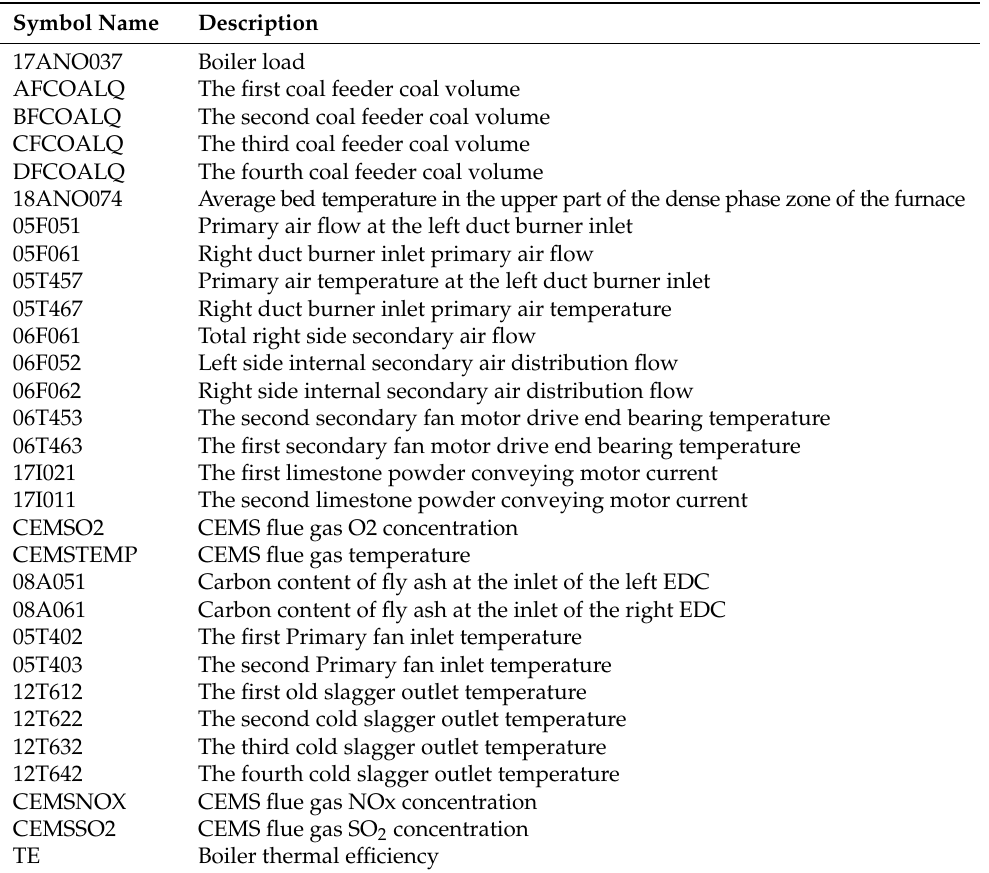
Table 6. Description of variable